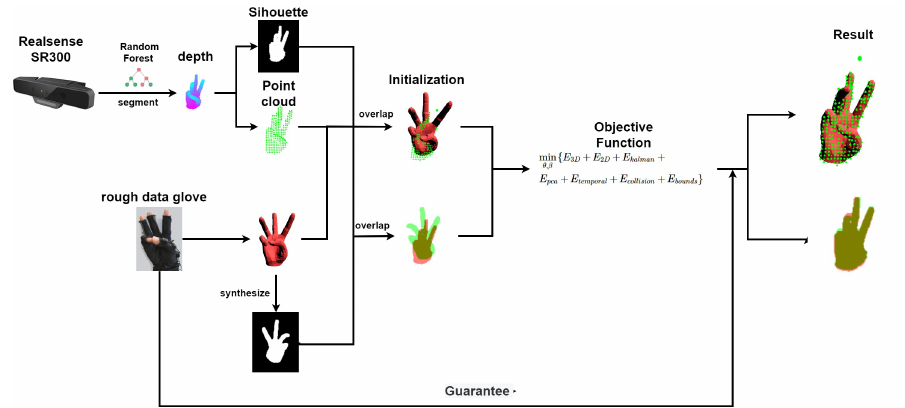
Figure 2. Overview of our system. Before tracking, the hand model has been prepared. During tracking, the workflow of the system is as follows: firstly, we acquire and process the inputs from the camera and the glove. For each acquired image, we extract a 3D point cloud and a 2D silhouette from the depth to provide the absolute measure. For the glove input, we get a rough hand pose for initialization. Secondly, we construct the objective function to measure the discrepancy between the hand model and the extracted 3D point cloud and 2D silhouette. Finally, we iteratively optimize the objective function by Levenberg–Marquardt approach to get the recovered hand motion. If the optimization failed, the input of the data glove provides a guarantee to ensure